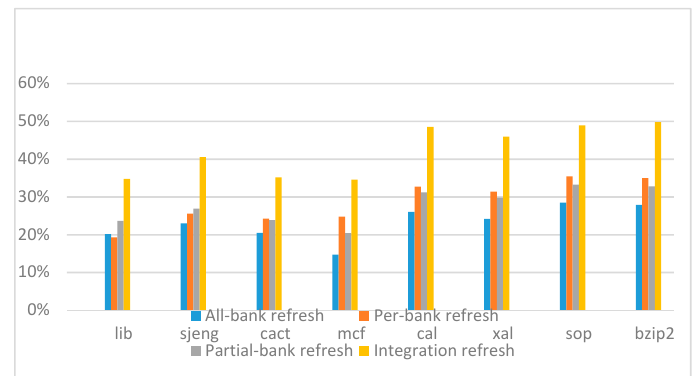
Figure 22. Energy reduction normalized to 1x granularity baseline (tRFC = 530 ns, weak row = 1%).